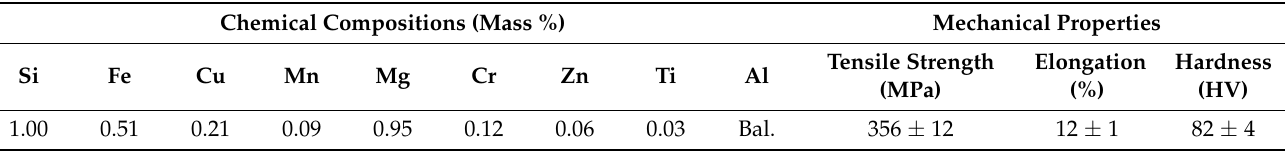
Table 1. Chemical composition and mechanical properties of the Al–Mg–Si alloy. Chemical Compositions (Mass